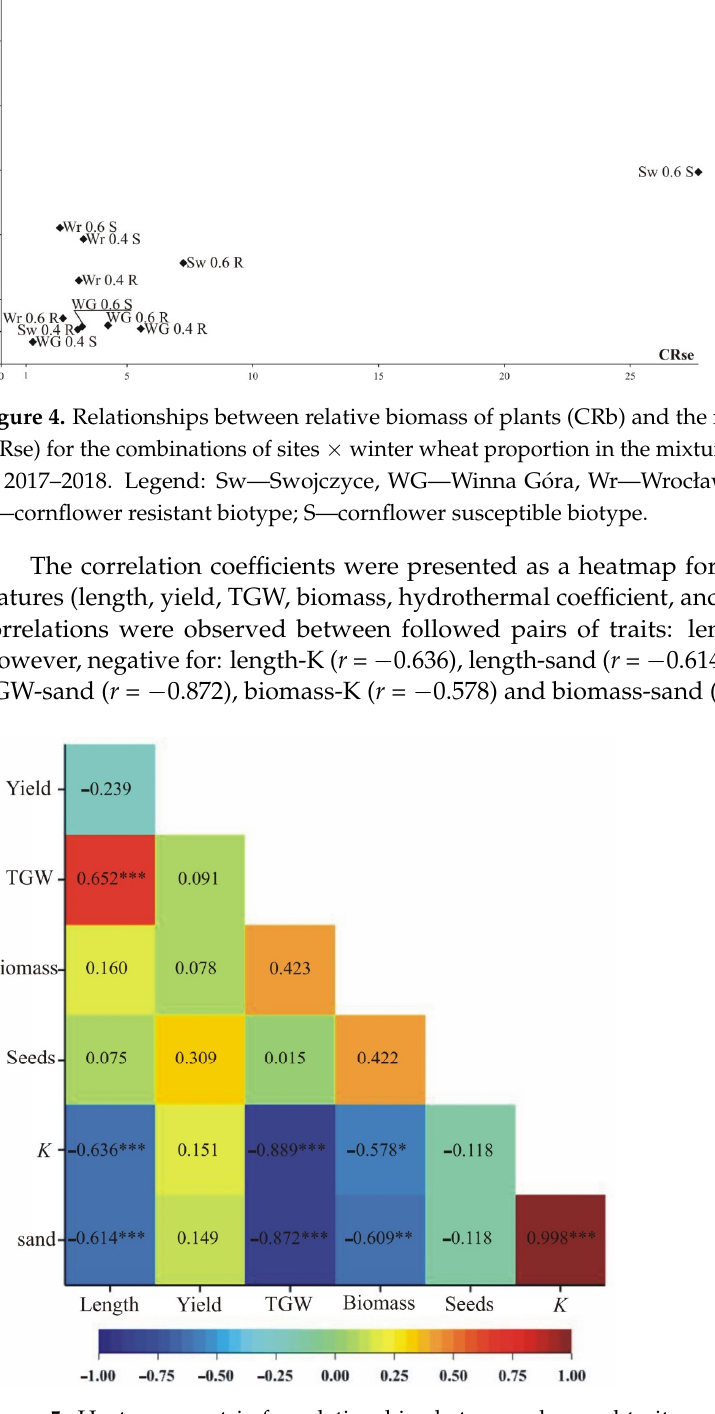
Figure 5. Heatmaps matrix for relationships between observed traits constructed on the basis of linear Pearson’s correlation coefficients, in season 2017–2018. * p < 0.05; ** p < 0.01; *** p < 0.001. The similarities in R and S competitive effects toward WW between different study sites in 2017-2018 was made on the basis of CVA. The first two (V 1 and V 2 ) canonical var- iables accounted for 96.64% of the total variability between the combinations of studied factors (Figure 6). The V 1 was significantly positively correlated with yield and TGW. The V 2 was negatively correlated with the length of the plant, TGW, and the number of grains per plant (Table S7).